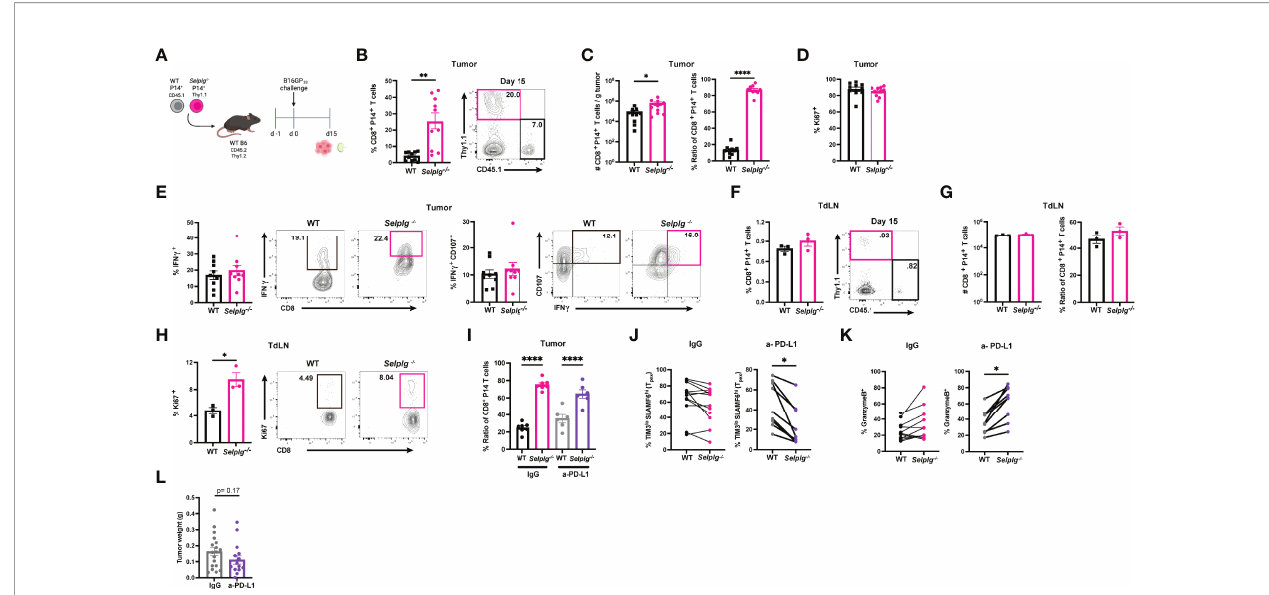
FIGURE 6 | PSGL-1-de fi cient CD8 + T cells are increased in melanoma tumors. WT and Selplg -/- P14 T cells were adoptively transferred at equal ratios into naïve WT recipients and injected with B16-GP 33 tumors s.c. one day later (A) . Frequencies of WT and Selplg -/- P14 + T cells in tumor (B) . T cell numbers per gram of tumor and ratio of WT and Selplg -/- P14 + T cells (C) . Frequencies of Ki67 + (D) , IFN- g + and IFN- g + CD107 + (E) of WT and Selplg -/- P14 + T cells. Frequencies of WT and Selplg -/- P14 + T cells in pooled tumor draining lymph nodes (TdLN) (F) . Numbers and ratio (G) and Ki67 + (H) of WT and Selplg -/- P14 + T cells in pooled TdLNs. Ratio of T cells (I) , Tpex frequencies (J) , and GranzymeB + T cells (K) , and tumor mass (L) in IgG or anti-PD-L1 treated mice. *p < 0.05, **p < 0.01, ****p < 0.001, (unpaired t -test). Data are representative of three independent experiments all with nine or more mice per group (error bars,